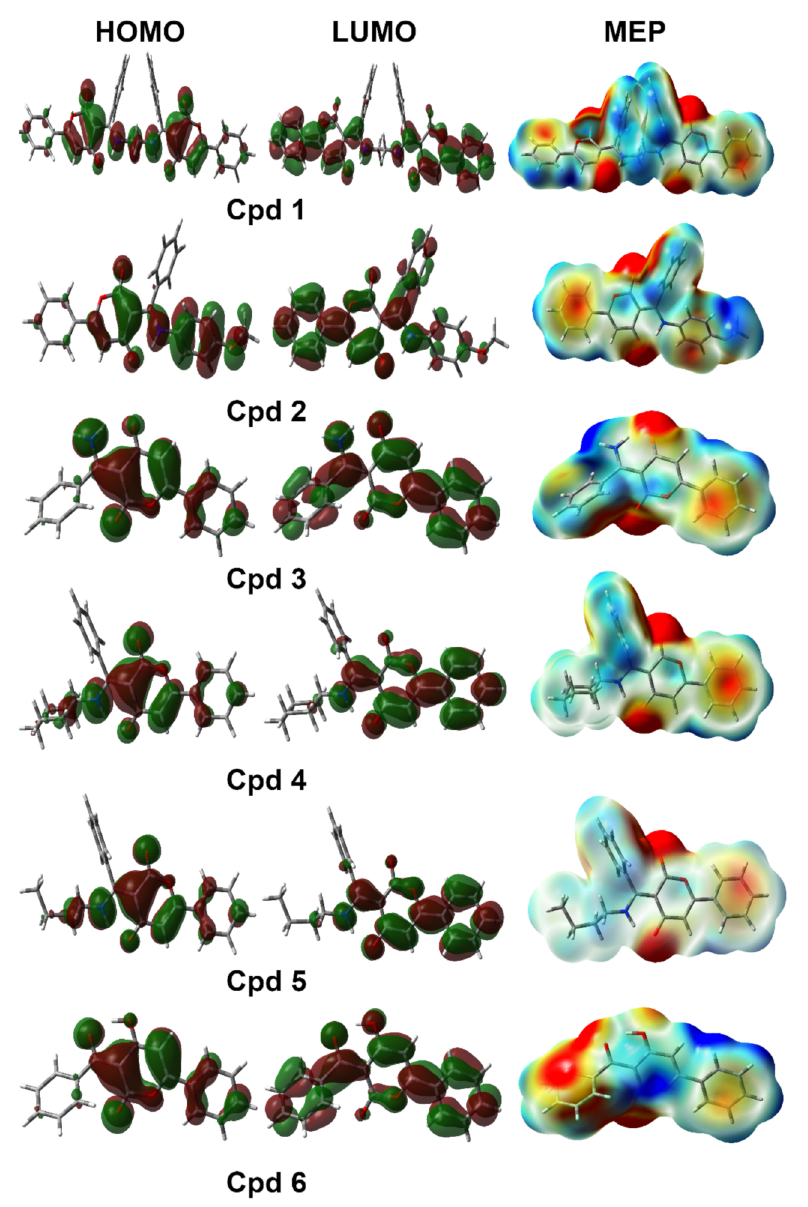
Figure 15. The MEP, HOMO and LUMO of the studied molecules. In MEP the red and blue colors indicate the most negative and most positive regions,